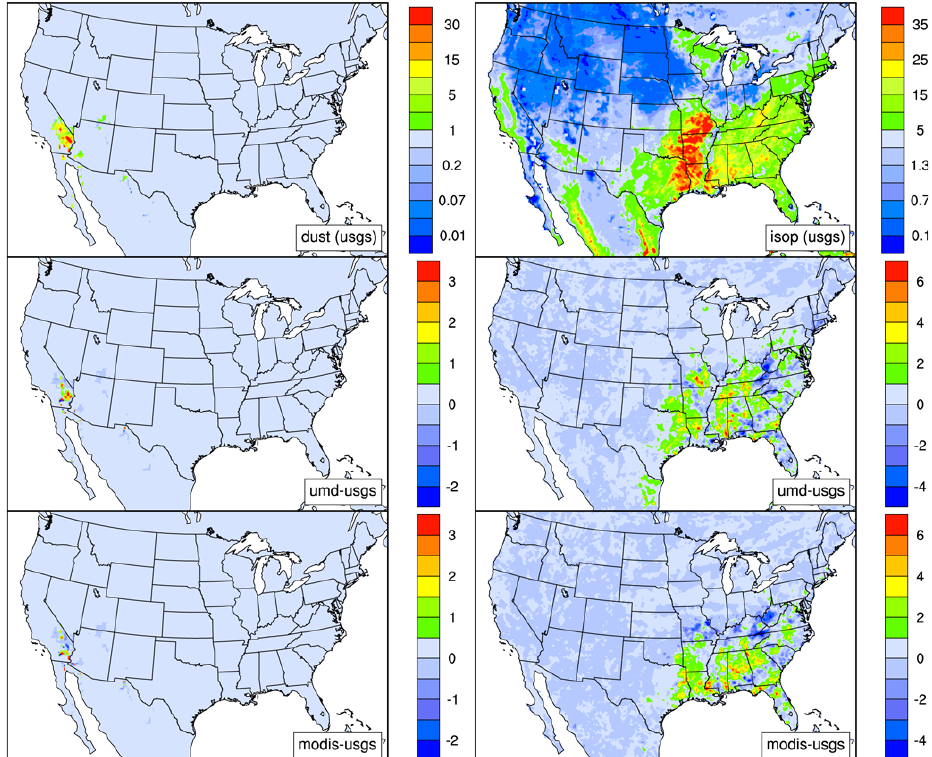
Fig. 7. Same as Fig. 3 except for average dust emissions (kgkm − 2 h, left panels) and biogenic isoprene emissions (molkm − 2 h, right